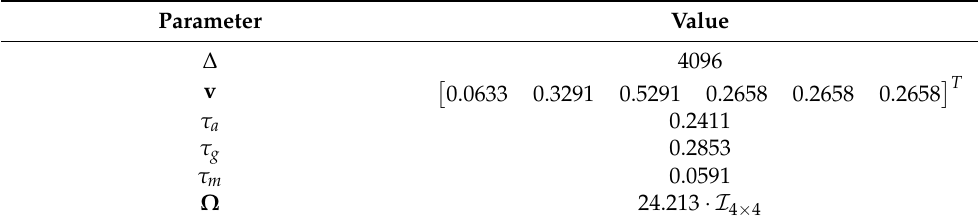
Table 2. Parameters used in numerical results ( I 4 × 4 represents the identity matrix of size 4 ×